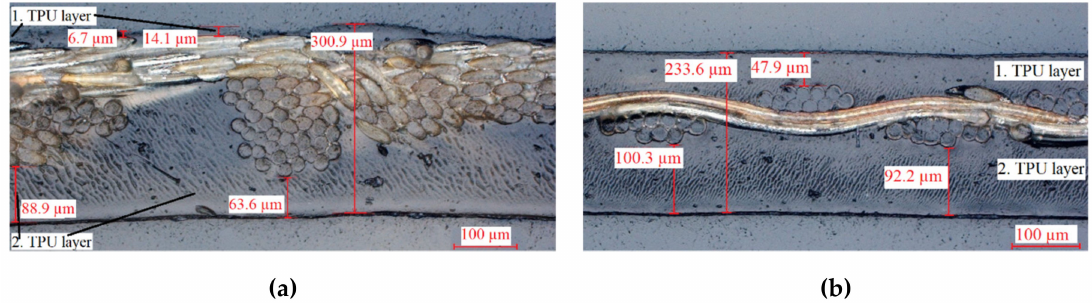
Figure 12. Micrographs of the elastic textile / polymer composites: ( a ) knitted conductive textile; ( b ) woven conductive